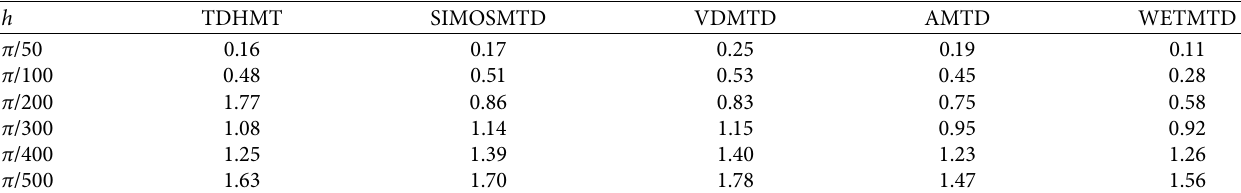
Table 11: Comparison of the CPU time of TDHMTwith the CPU time of other existing methods, namely, SIMOSMTD, VDMTD, AMTD, and WETMTD for Example 2.